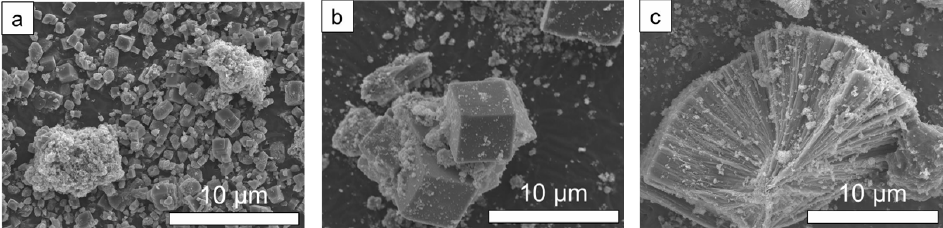
Figure 2. SEM images of the solids obtained under autogenous ( a ), 50 MPa ( b ) and 200 MPa ( c ) at 150 °C for 24 h using the diluted synthesis mixture (H 2 O/Al 2 O 3 = 50). The relative chemical composition of the solids obtained under autogenous pressure (AP), 50 MPa and 200 MPa at different synthesis times, is shown in Figure 3 and Table S1. The relative Al content of the solids prepared under AP decreases quickly during the first 5 h, from 61% to 54%, showing a value around 50% at long synthesis time, while the relative P content increases in the same time interval, from 28% to 35%; the Si content slightly decreases from 11% to 9%. The main changes in the chemical composition of the solids occur during the nucleation and initial crystal growth steps, showing small changes in the chemical composition after 15 h when the SAPO-18 material is fully crystallized. Crystalline SAPO-18 presents an Al/P ratio higher than 1, while the (Si + P)/Al ratio is close to 1, suggesting the Si atoms are inserted in the framework following mechanism where one P is substituted by one Si (1 P → 1 Si). The samples obtained under 200 MPa shows fluctuations in the chemical composition with time that could be attributed to